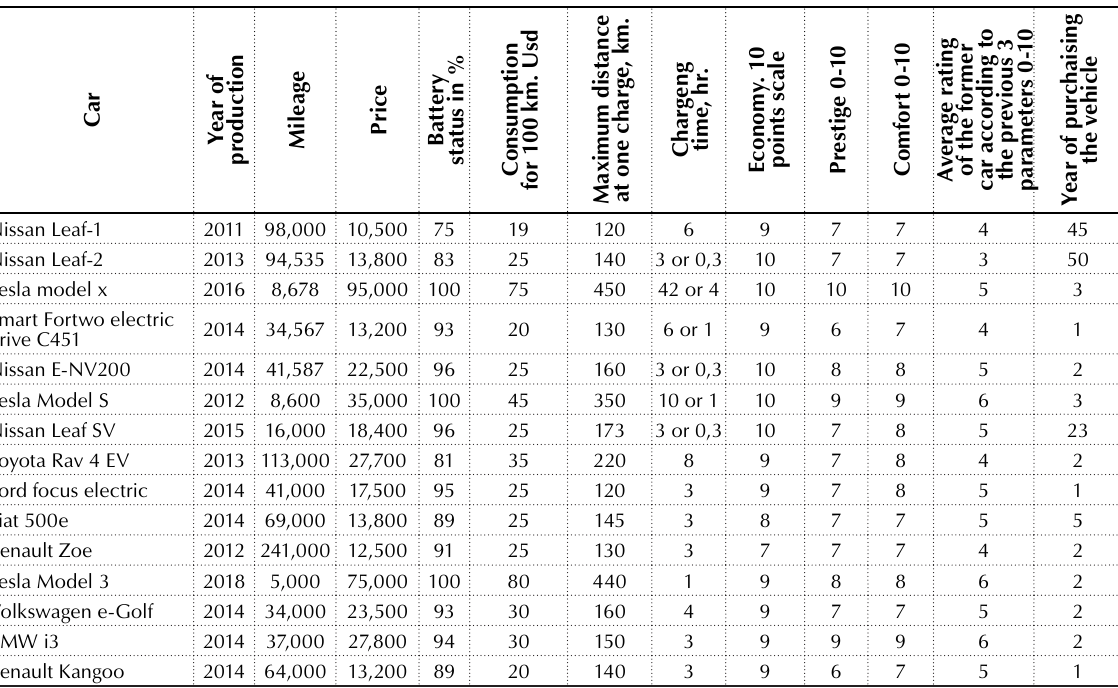
Table 1. Statistics of input data of technical parameters and comparative characteristics of key parameters of electric